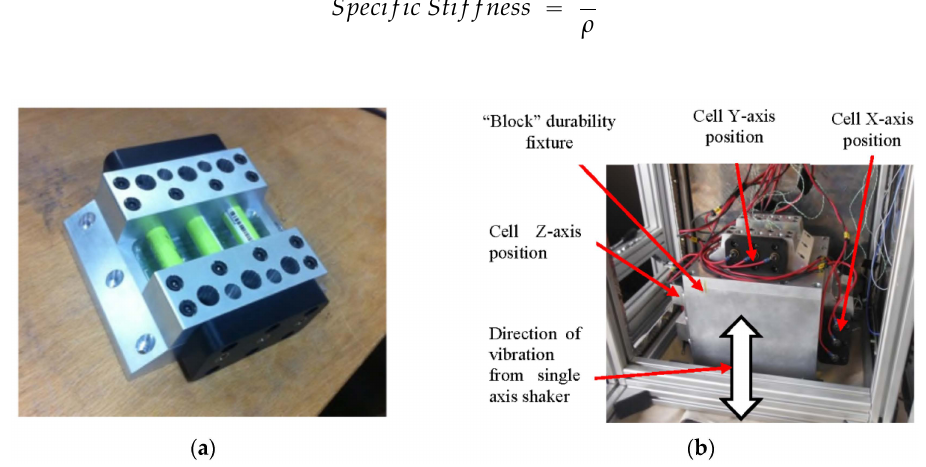
Figure 1. ( a ) Single test fixture ( b ) Assembled test fixture on shaker table with test positions.